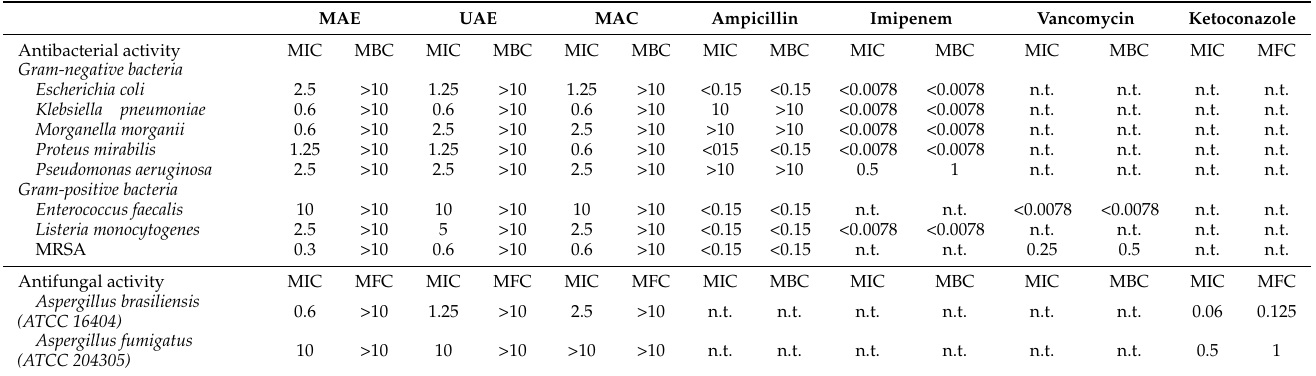
Table 6. Antibacterial and antifungal activity of P. granatum leaf hydroethanolic extracts against clinical